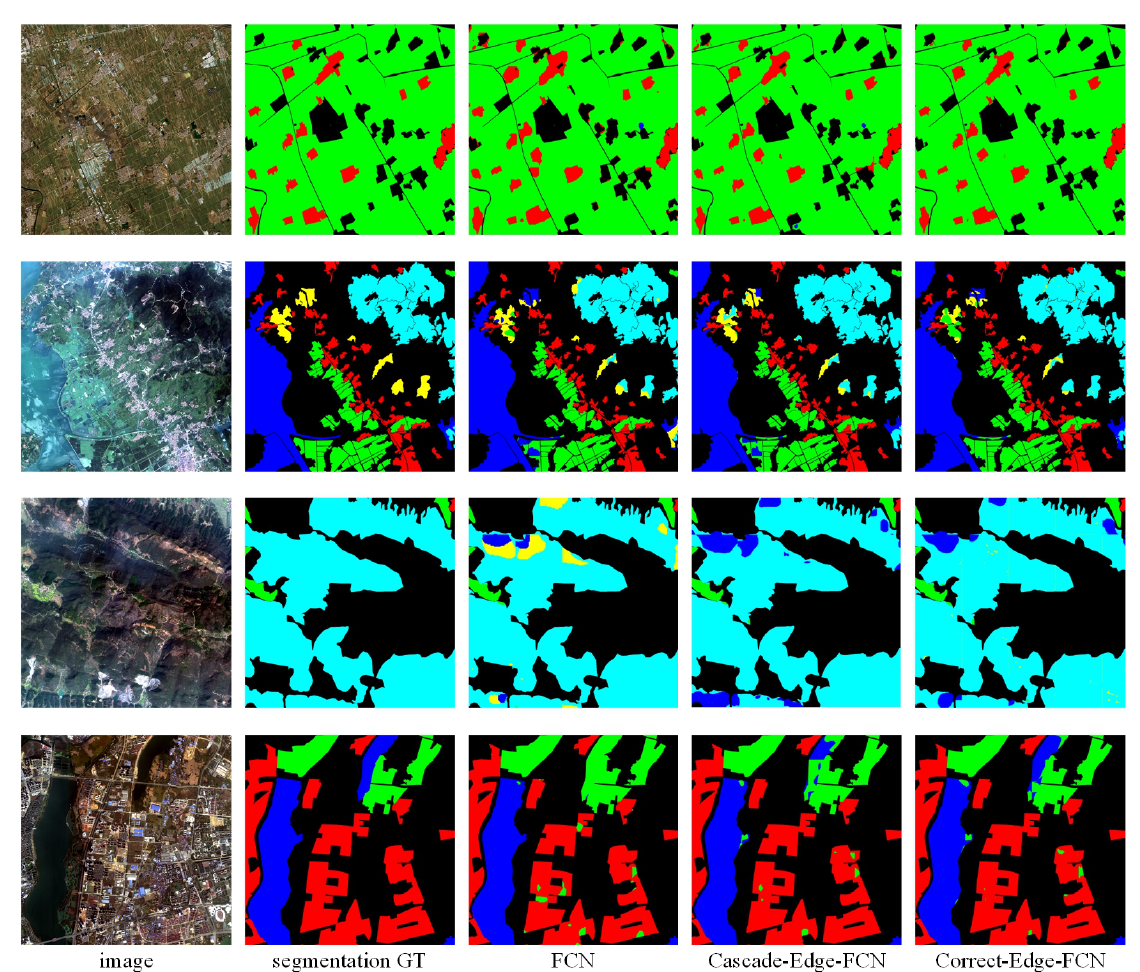
Figure 15. Some image samples and the segmentation results of GID